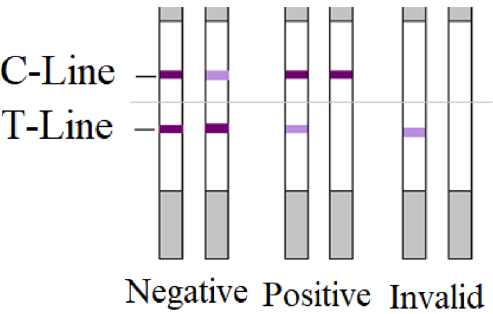
Figure 7. Negative sample (−): the sample is free of tetracyclines residues if the intensity of the T-line is greater than the C-line, and it is lower than limitation if their intensities are similar. Positive sample (+): TCs antibiotics residues are equal to the limitation if the intensity of the T-line is lighter than the C-line, and it is greater than limitation if only the C-line is visible. Invalid result: if the C-line is